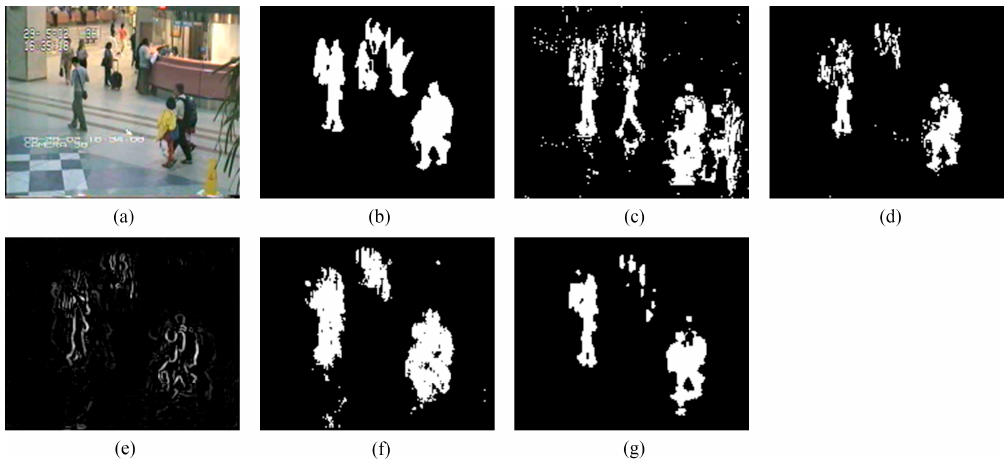
Figure 7. Detection results of the 10th frame of AP96 (Frame 3409): ( a ) input frame; ( b ) ground-truth reference; ( c ) result of ViBe; ( d ) result of PCP; ( e ) result of TD-2DDFT; ( f ) result of TD-2DUWT; ( g ) result of TD-3DDWT.